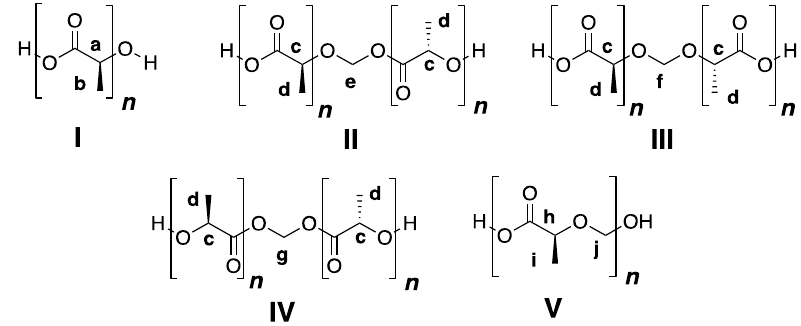
Figure 3. Plausible molecular entities present in the MeDOX polymerization mixture according to NMR.